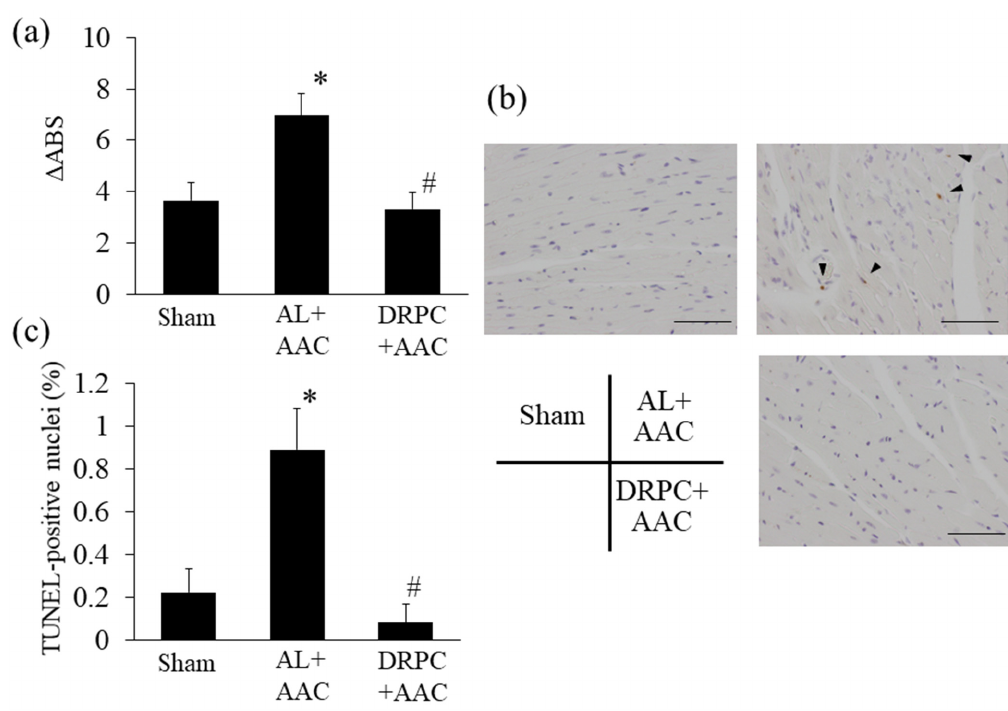
Figure 8. Effects of dietary restriction preconditioning on pressure overload-induced cardiac mitochondrial injury and apoptosis. ( a ) Mitochondrial permeability transition was assessed by light scattering changes 2 weeks after surgery (Sham: n = 8, AL+AAC: n = 7, DRPC+AAC: n = 5). ( b ) Representative photomicrographs of deoxynucleotidyl transferase-mediated dUTP nick end-labeling (TUNEL)-stained LV cross-sections 2 weeks after surgery. Arrowheads indicate TUNEL-positive nuclei. Bars indicate 100 μ m. ( c ) Ratio of TUNEL-positive nuclei 2 weeks after surgery (Sham: n = 5, AL+AAC: n = 5, DRPC+AAC: n = 5). * p < 0.05 versus Sham. # p < 0.05 versus AL+ AAC.